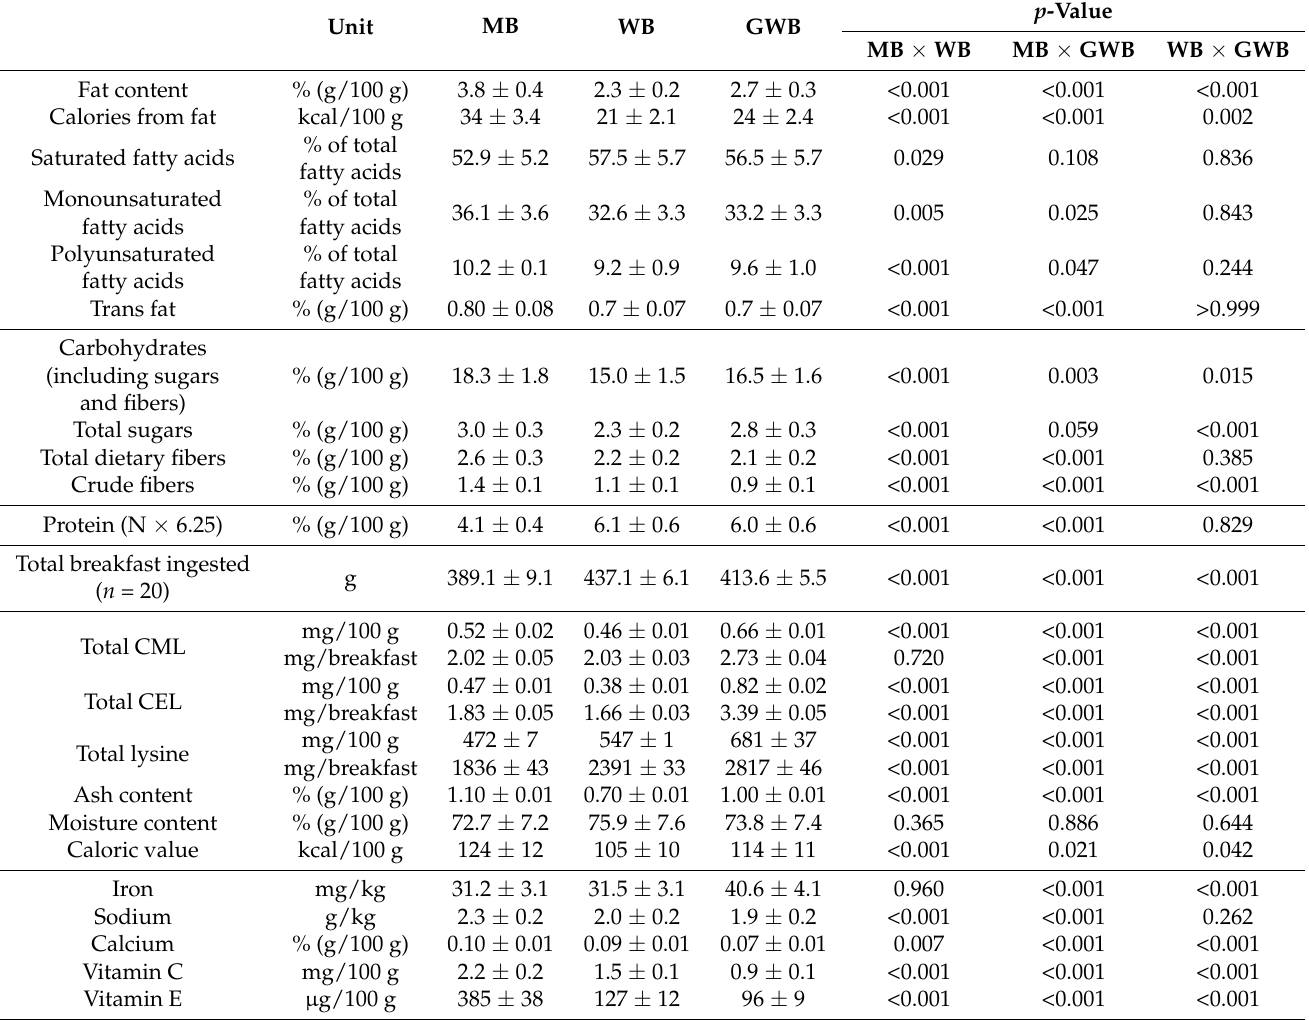
Table 1. Characteristics of the three